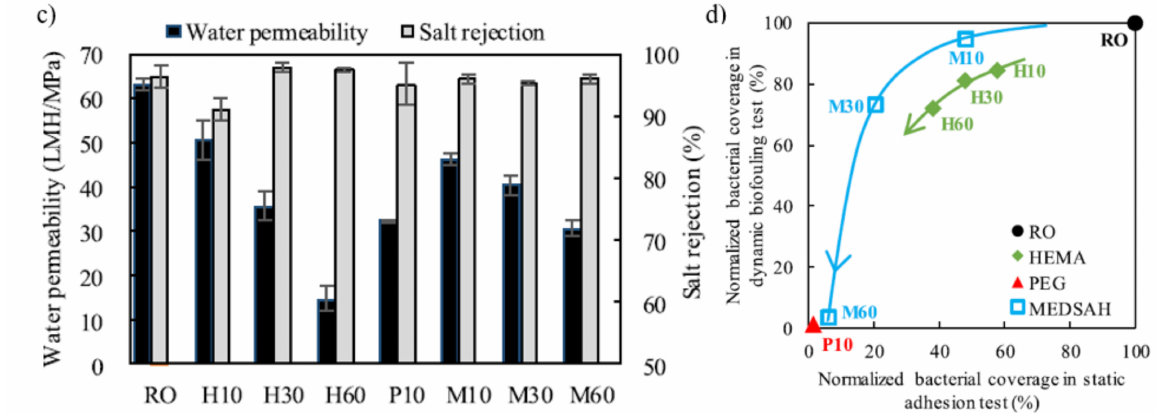
Figure 10. ( a ) Grafting of ((3-methacryloylamino) propyl) dimethyl(3-sulfopropyl) ammonium hydroxide (pMEDSAH) onto PA) thin film composite (TFC) nanofiltration (NF) membrane via surface-initiated RAFT polymerization; ( b ) Fouling resistance ratio of the prepared NF membranes. The BIBB-stabilized and pMEDSAH grafted membranes are referred as TFC-OHi-Bj and TFCZ-t, where i, j, and t refer to the DAPM (wt.%), BIBB (wt.%), and polymerization time (minute); ( c ) Water permeability and salt rejection of pHEMA-, pPEG-, and pMEDSAH-grafted membranes with different polymer- ization durations; ( d ) Relationship between normalized bacterial coverage in static bacterial adhesion and in dynamic biofouling filtration [140]. The direction of arrows means the increase of polymerization